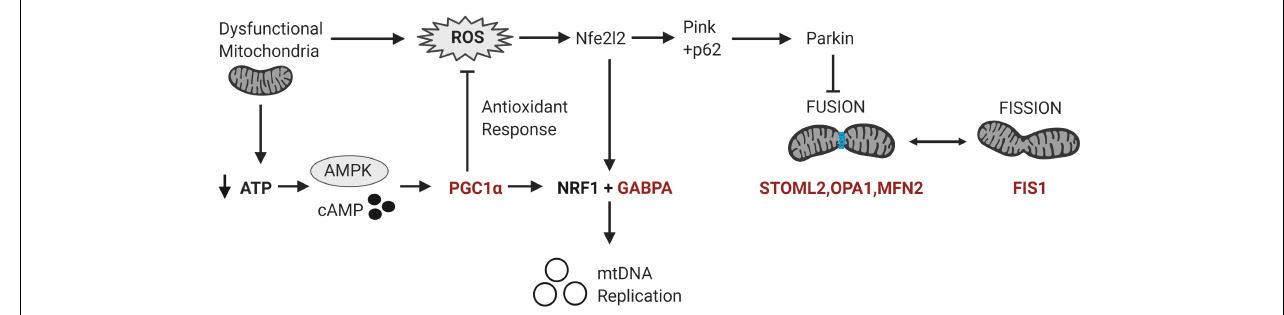
FIGURE 3 | Differentially methylated genes converge on pathways regulating mitochondrial homeostasis in response to metabolic and oxidative stress. Mitochondrial homeostasis is maintained by differentially methylated genes (in red) involved in mitochondrial biogenesis, fission and fusion that converge on the regulation of mitochondrial copy number in response to metabolic and oxidative stress. Metabolic stress, which decreases ATP production, activates cAMP and AMPK signaling leading to the transcription and activation of PGC-1 α . PGC-1 α upregulates the expression of Nrf1 and GABPA which induce the transcription of the mitochondrial transcription factors to facilitate mitochondrial biogenesis. PGC-1 α also upregulates the transcription of antioxidant enzymes to modulate oxidative stress or ROS levels. Oxidative stress activates the redox-sensitive Nfe2l2 pathway, which upregulates both GABPA and the Pink-Parkin pathway that controls mitophagy, fission and fusion (Nfe2l2 = nuclear factor erythroid 2-related factor 2; NRF1 = Nuclear respiratory factor 1; p62 = ubiquitin-binding protein p62; Pink = PTEN-induced kinase 1; ROS = reactive oxygen species).